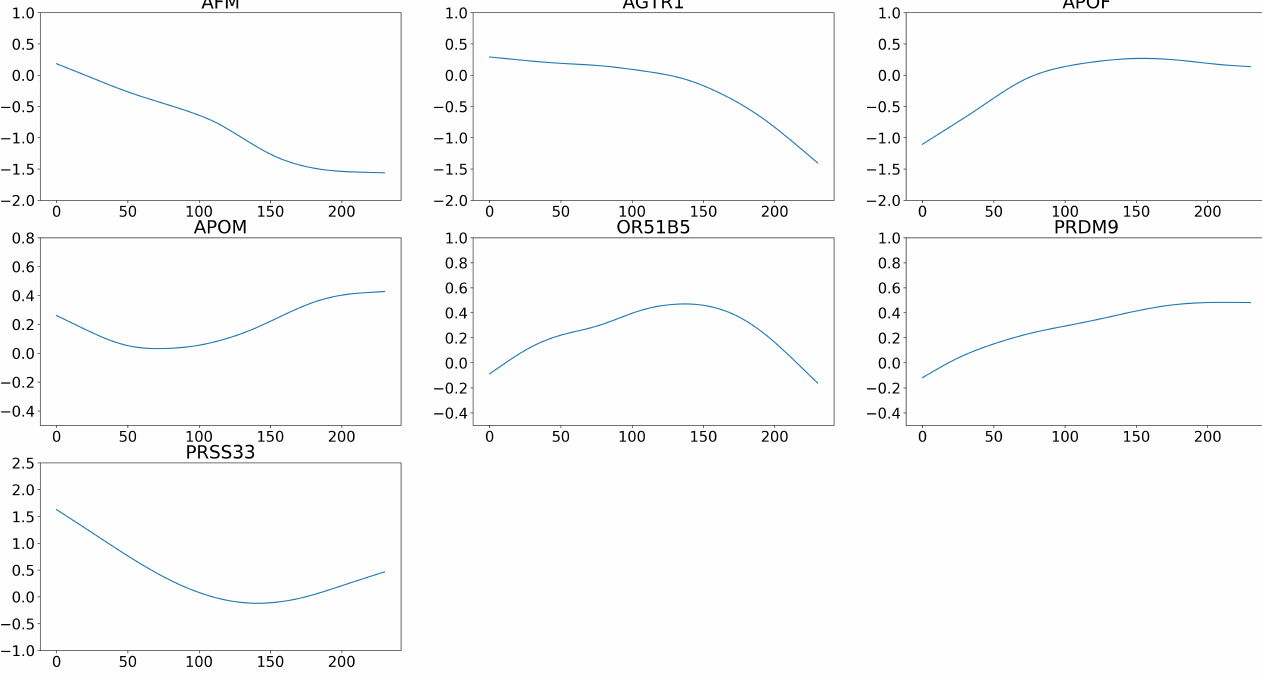
Figure A5. Analysis of LUAD data using the proposed approach: estimated coefficients of the 7 genes for all subjects. The x -axis represents the subjects, and the y -axis represents the coefficient values.